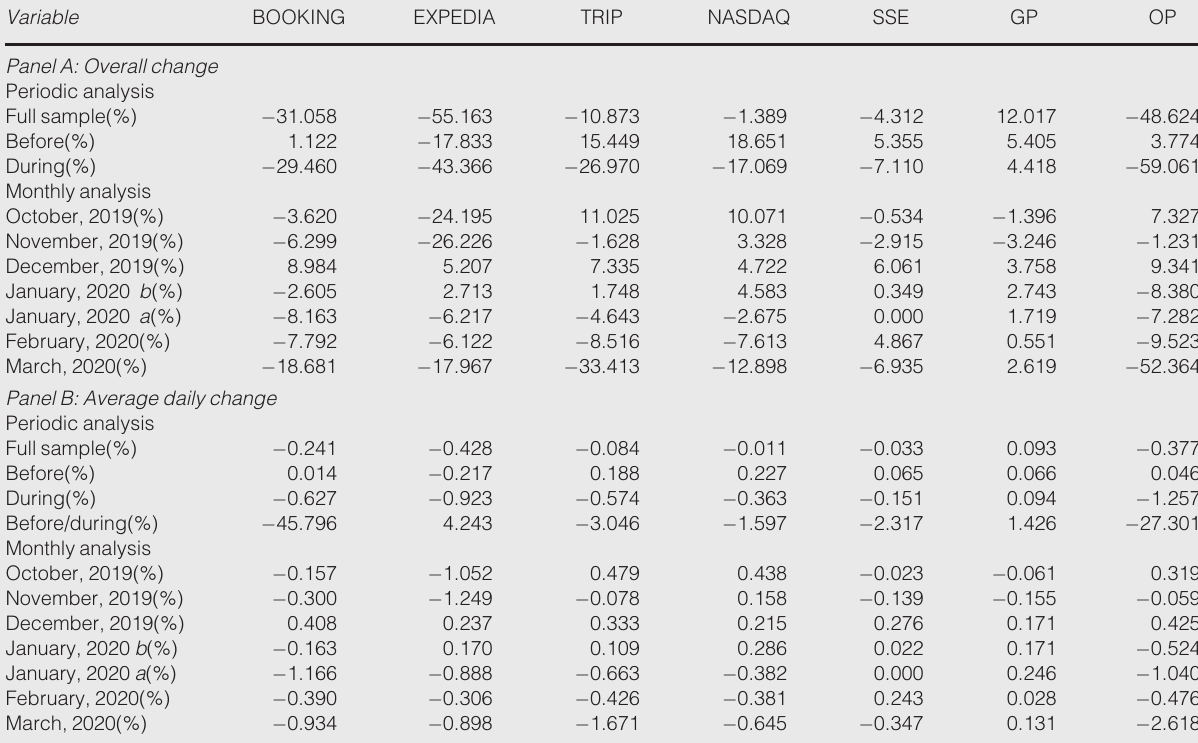
Table 2 Percentage change of stock and commodity variables Variable BOOKING